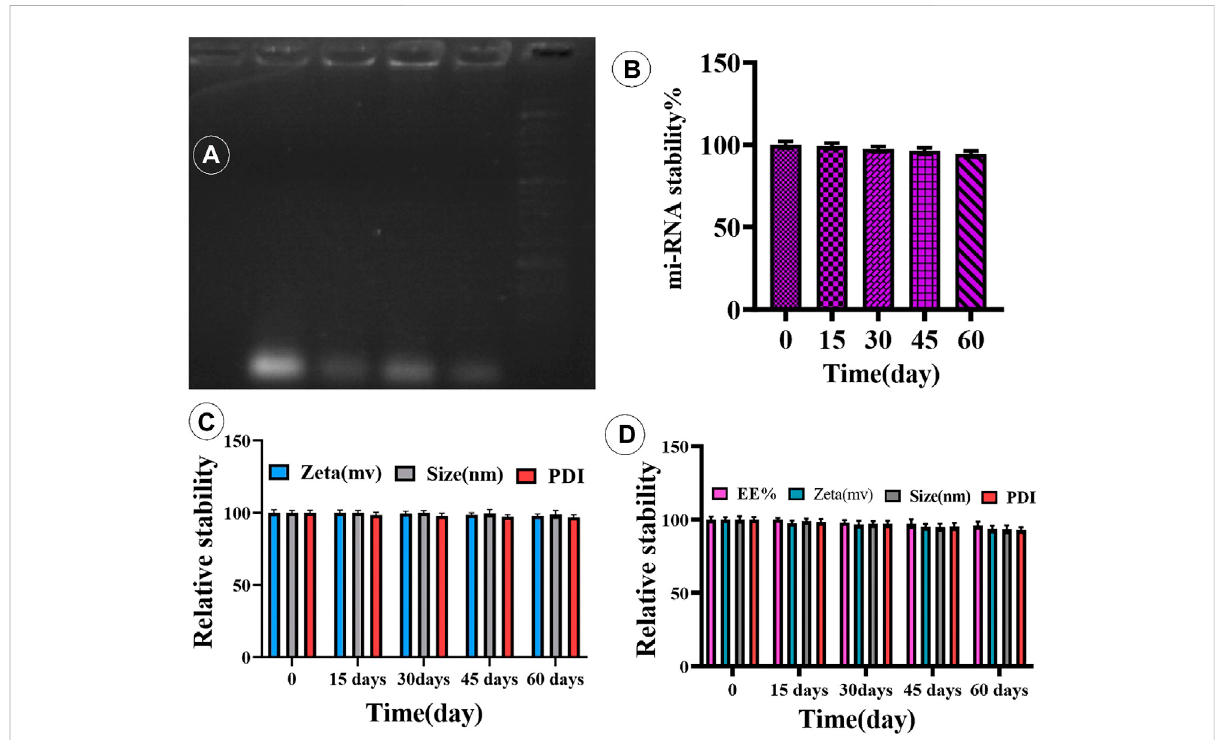
0.15 (cationic niosomes:mi-RNA34a). The loading of mi-RNAs